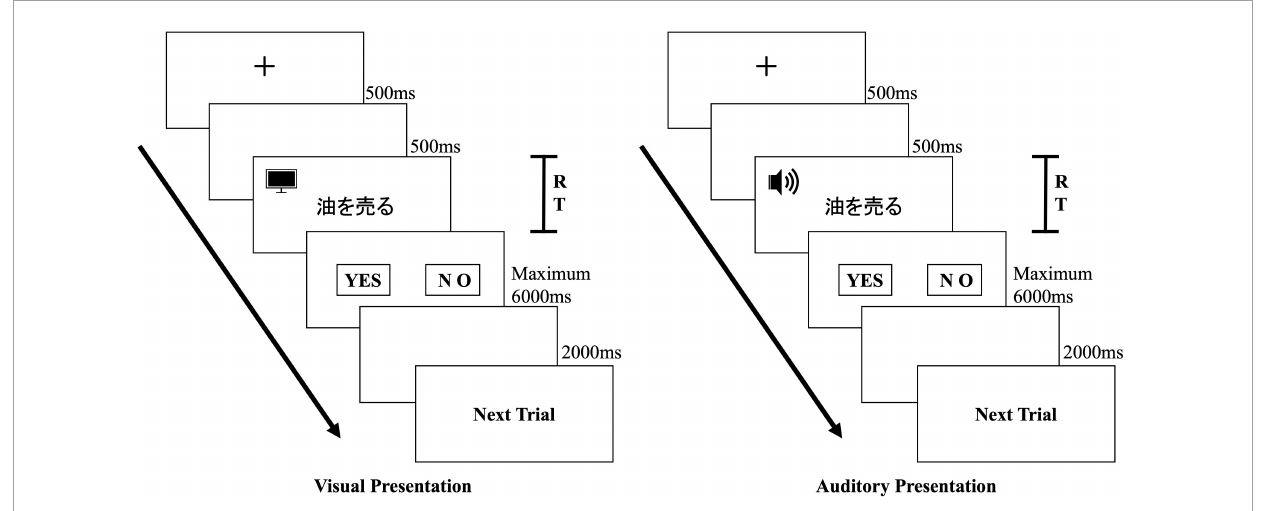
FIGURE1 Flow of one experiment trial in the visual and auditory presentation